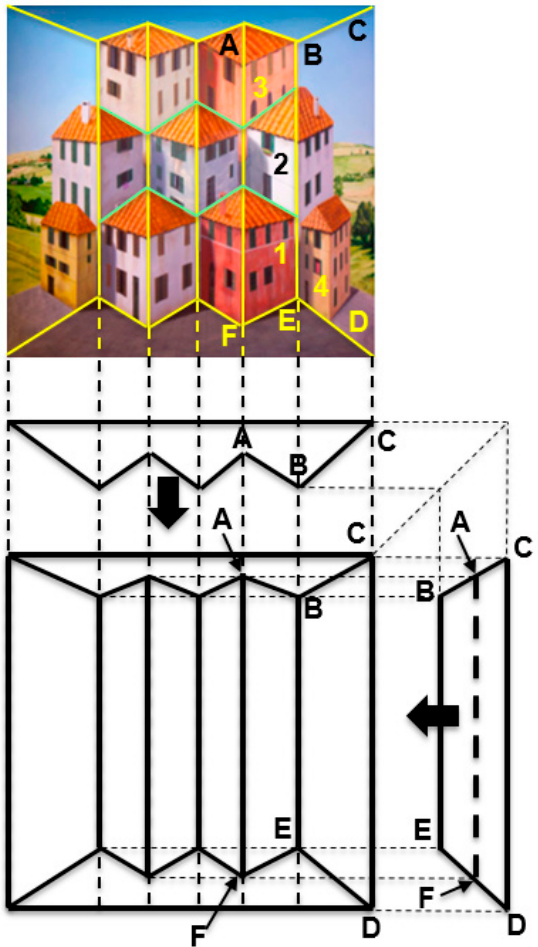
Figure 6. “Poetry in Motion” (2012). See text for details.